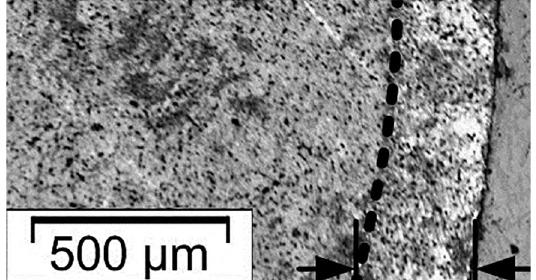
Figure 8. Optical microscopy of a pressed sample border sintered at 1350 °C. Table 3. Chemical analysis via EDS of injection molded sample sintered at 1375 ºC.